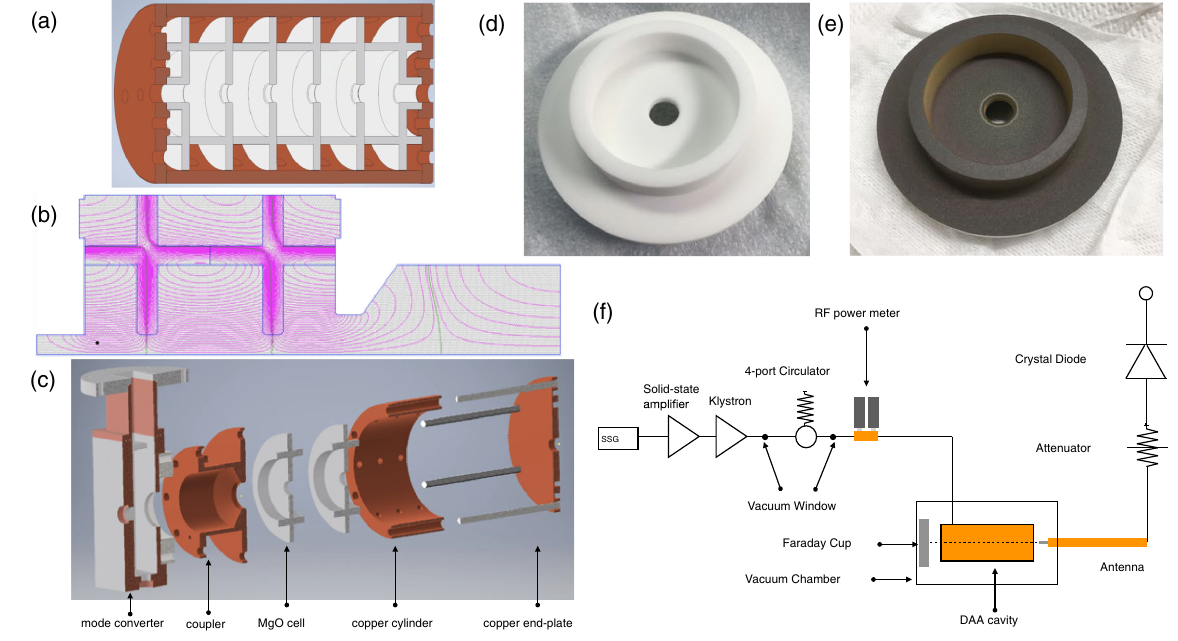
FIG. 2. (a) Schematic representation of the original DAA cavity with five cells (DAA5) [2]. (b) Cross section of the electric field of the accelerating mode calculated using S uper F ish . (c) Development view of the two-cell cavity (DAA2). (d) MgO cell of DAA2 without coating and (e) with DLC coating with a thickness of 0 . 5 ½ μ m (cid:2) . (f) rf system of the high-power conditioning from the klystron to the measurement of stored power through the